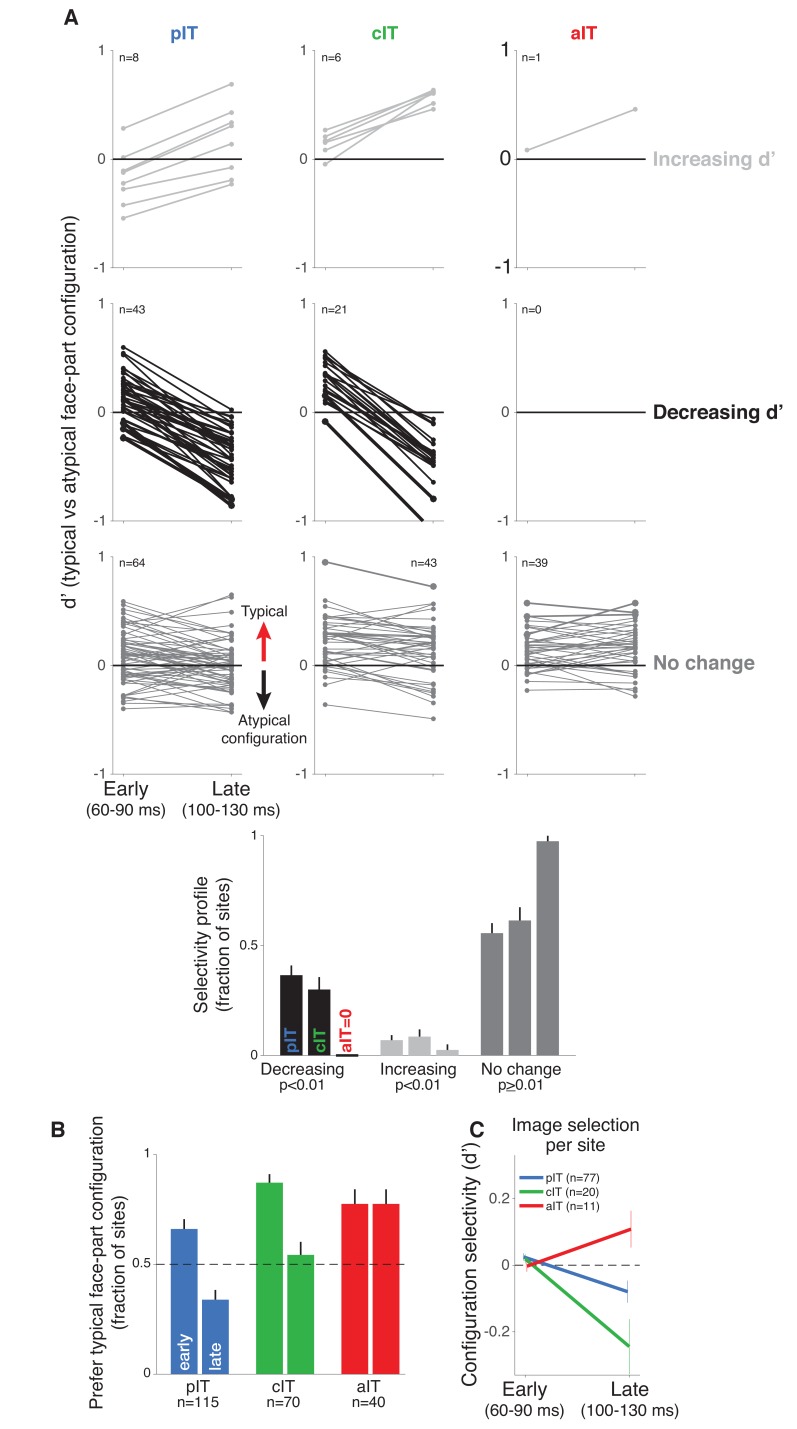
Time course of neural response preferences in pIT, cIT, and aIT for images with typical versus atypical face-part configurations.(A) Preferences for typical vs atypical part arrangements for each site are plotted in both early (60–90 ms post image onset) and late (100–130 ms) time windows. Sites are grouped based on region (pIT, cIT, aIT) and whether they showed a significant change in selectivity from early to late time windows (light gray = increased preference, black = decreased preference, and dark gray = no change in preference for typical versus atypical face-part configurations, significance tested at p < 0.01 level; example sites from Figure 2 are plotted using thicker, darker lines). Many sites in pIT and cIT showed a decreasing signal for the typical face-part configuration context versus atypical configuration contexts over time (black lines, middle row, left and center panels). In contrast, no sites in aIT had this dynamic (middle row, right panel). (B) The fraction of sites whose responses showed a preference for images of typical, face-like arrangements of the face parts in pIT (blue), cIT (green) and aIT (red) in the early (60–90 ms) and late (100–130 ms) phase of the response. Note that, in the late phase of the response, most pIT neurons responded more strongly to atypical arrangements of face parts. (C) Selectivity measured for images driving similar responses within a site. This procedure ensured matched initial responses on a site-by-site basis rather than using a fixed set of images based on the overall population response (i.e. the fixed image set of Figure 1B; here, the initial d’ for 60–90 ms is close to zero when images are selected site by site). Although initial response differences were near zero when using site based image selection, a late phase signal that was stronger for atypical face-part configurations still emerged in pIT and cIT but not in aIT similar to the decreasing selectivity profile observed when using a fixed image set for all sites.